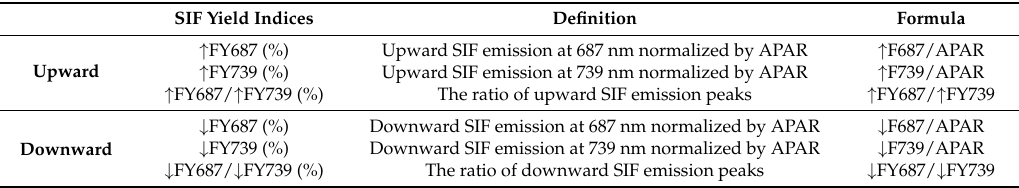
Figure 3. Distributions of the SIF peak emission positions in winter wheat (( A ) the red region, ( B ) the far-red region). Table 2. SIF yield indices used in this study.